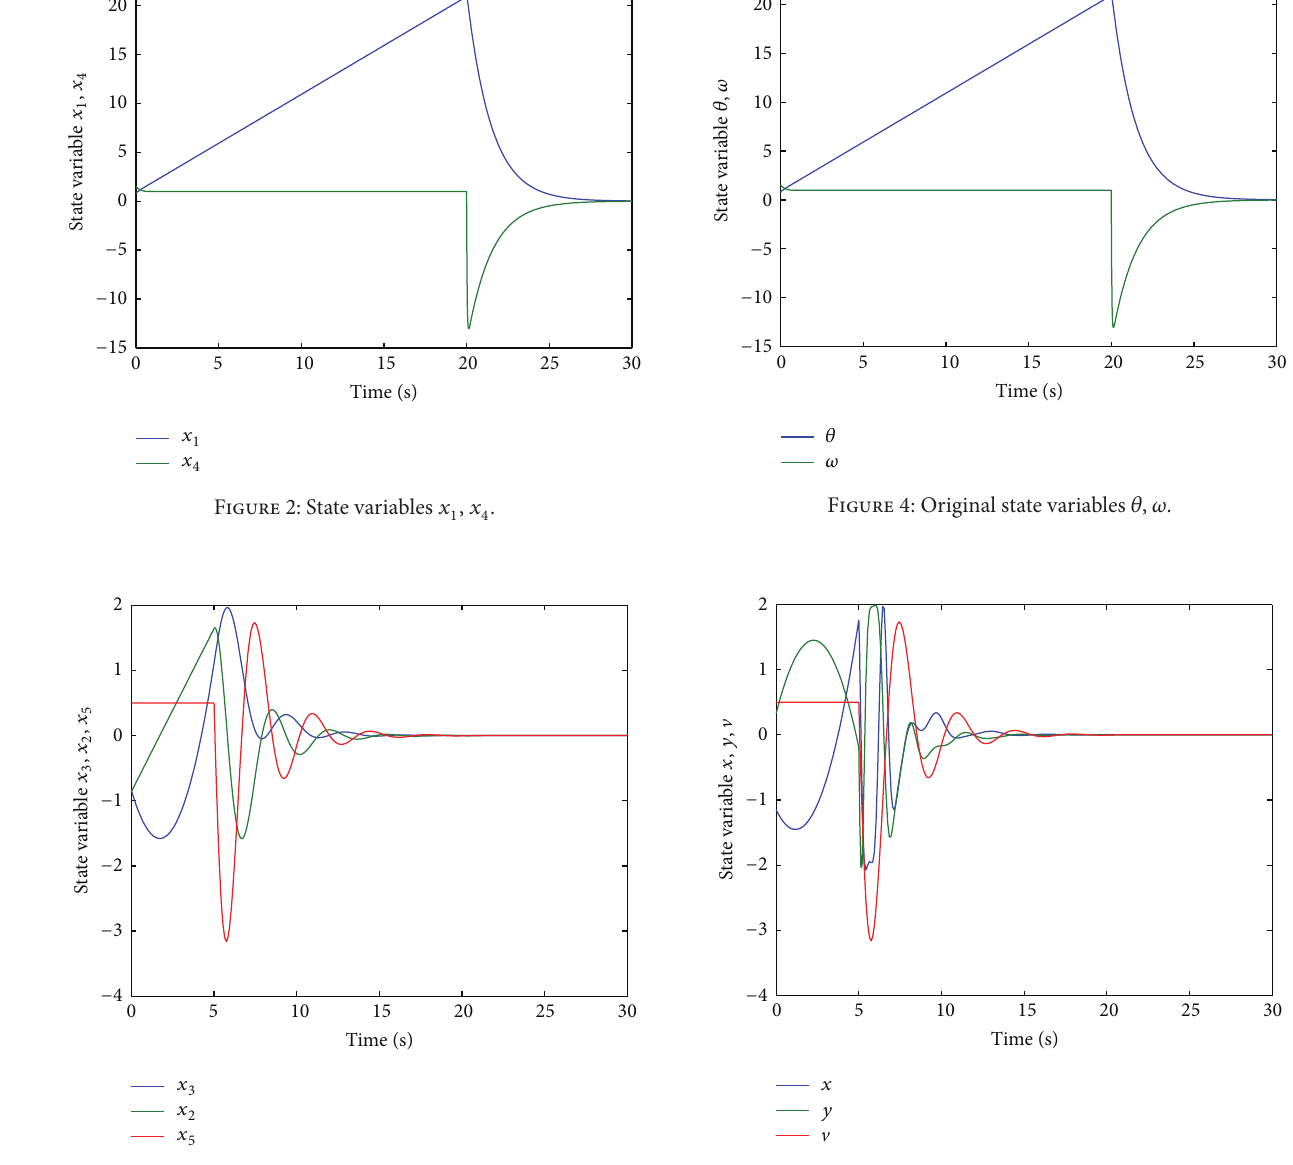
Figure 5: Original state variables 𝑥 , 𝑦 , and V